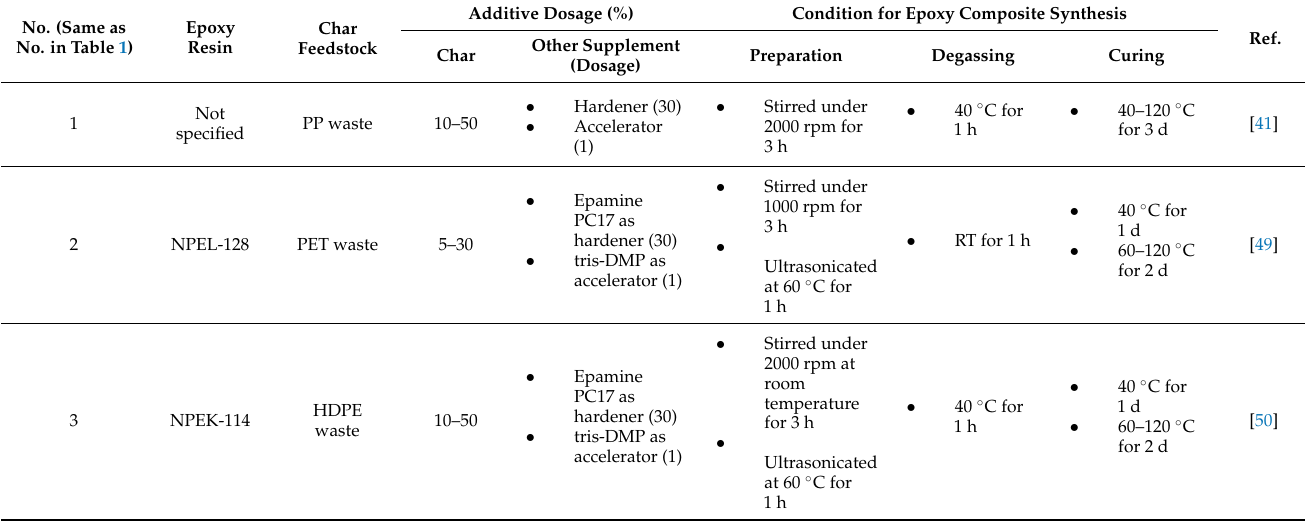
Table 2. Synthesis methods of epoxy composite using the plastic-waste-derived char as an